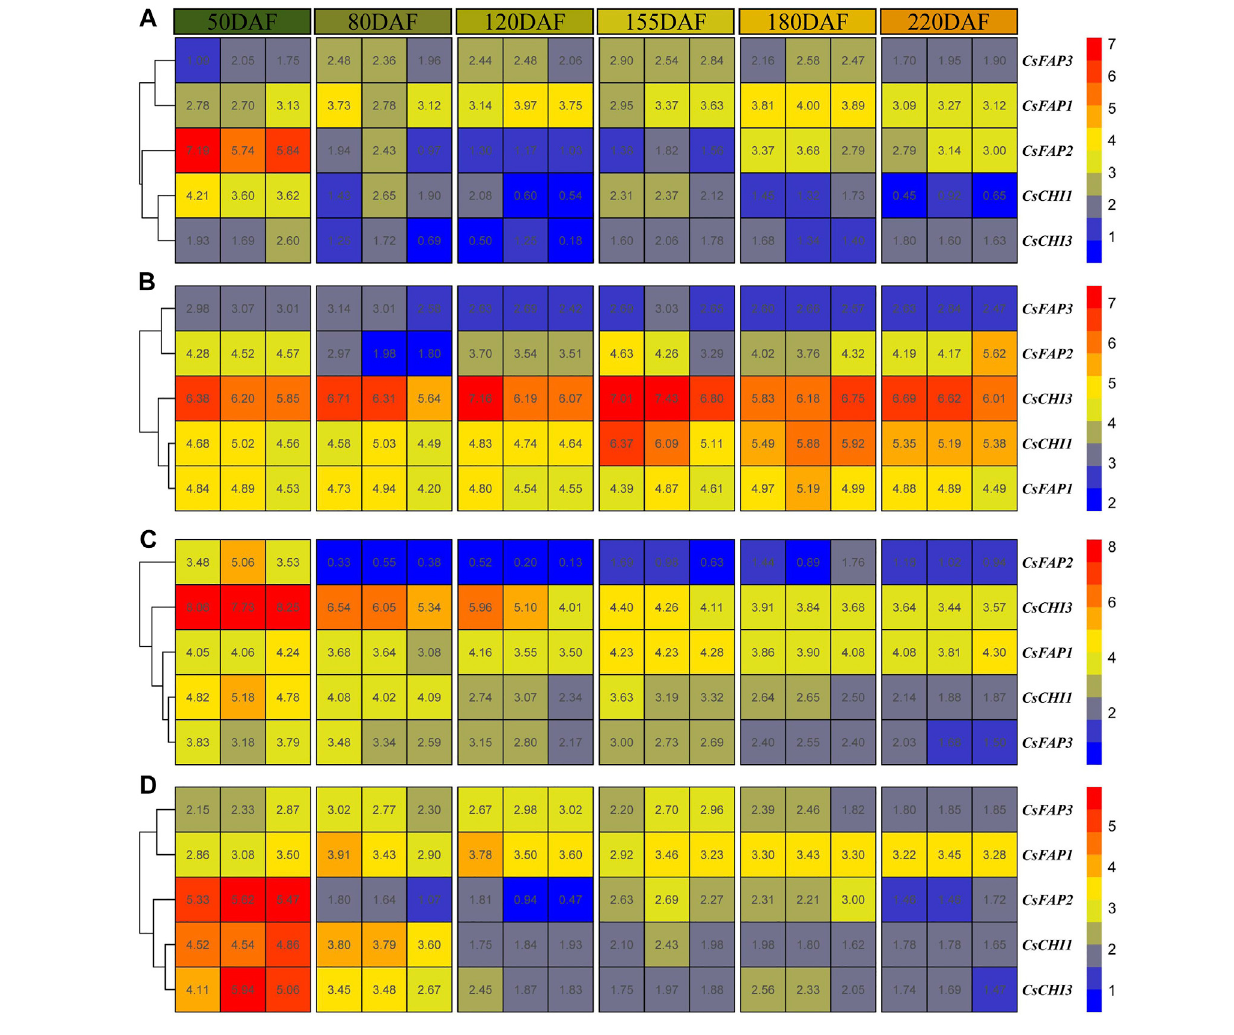
Frontiers in Genetics |